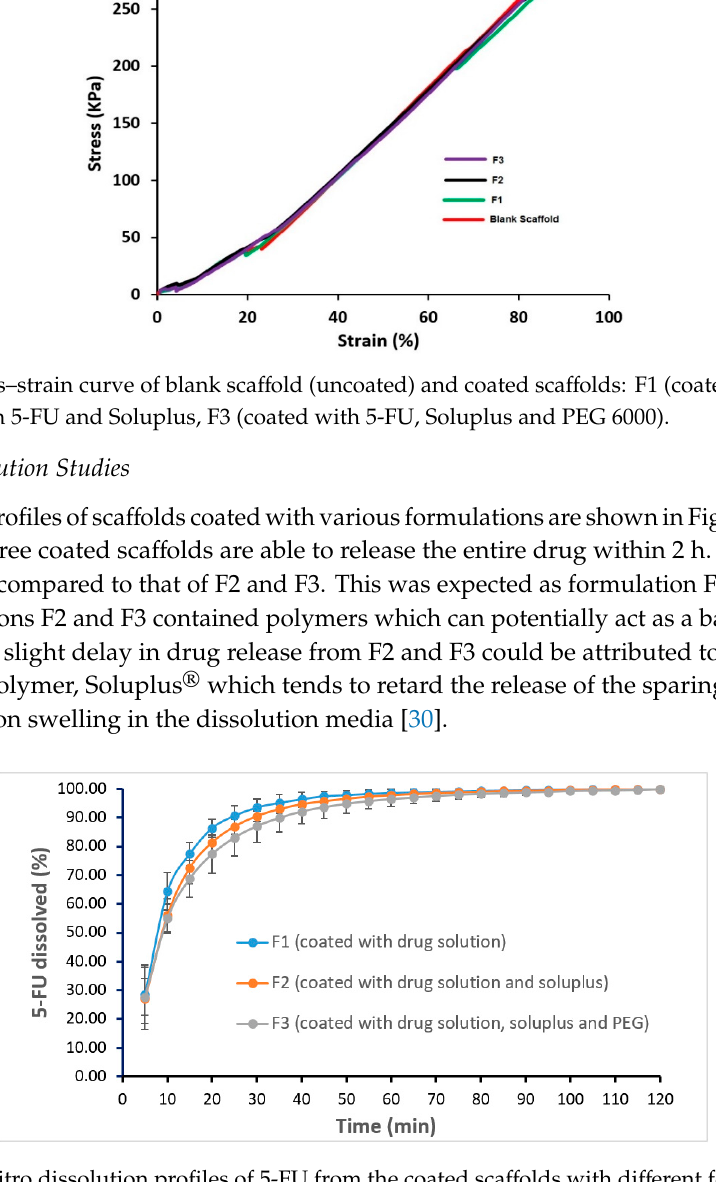
Figure 9. In vitro dissolution profiles of 5-FU from the coated scaffolds with different